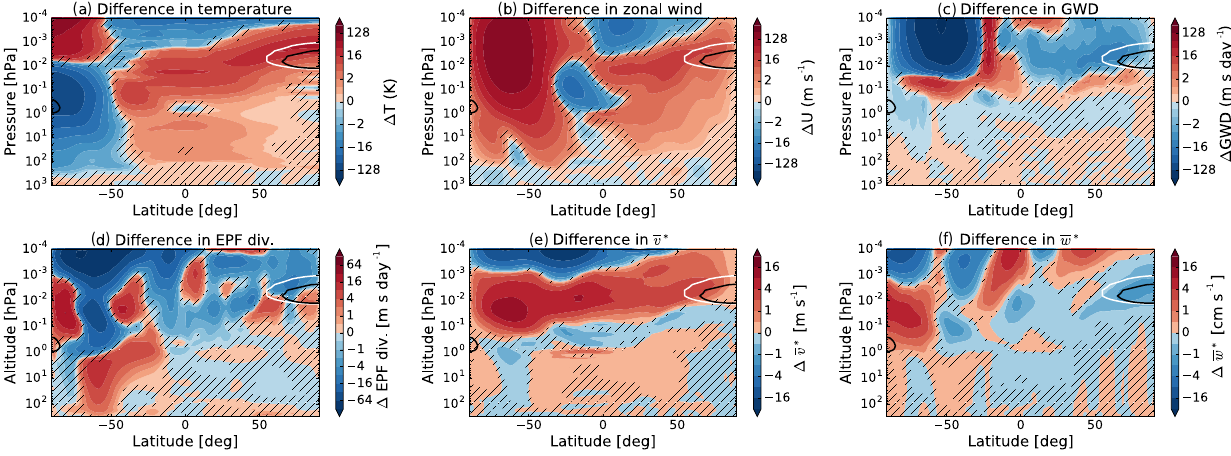
Figure 1. The difference in zonal-mean temperature (a) , zonal-mean zonal wind (b) , gravity wave (GW) drag (c) , EP flux divergence (d) and the transformed Eulerian-mean residual circulation velocity v ∗ (e) and w ∗ (f) for July: (run without winter GWs) minus (control run). The white contour indicates the summer polar mesopause region where the temperatures are below 150K for the control run. The black contour indicates the region where the temperature is below 150K for the run without the GWs in winter. The hatched areas are regions where the data does not reach a confidence level of